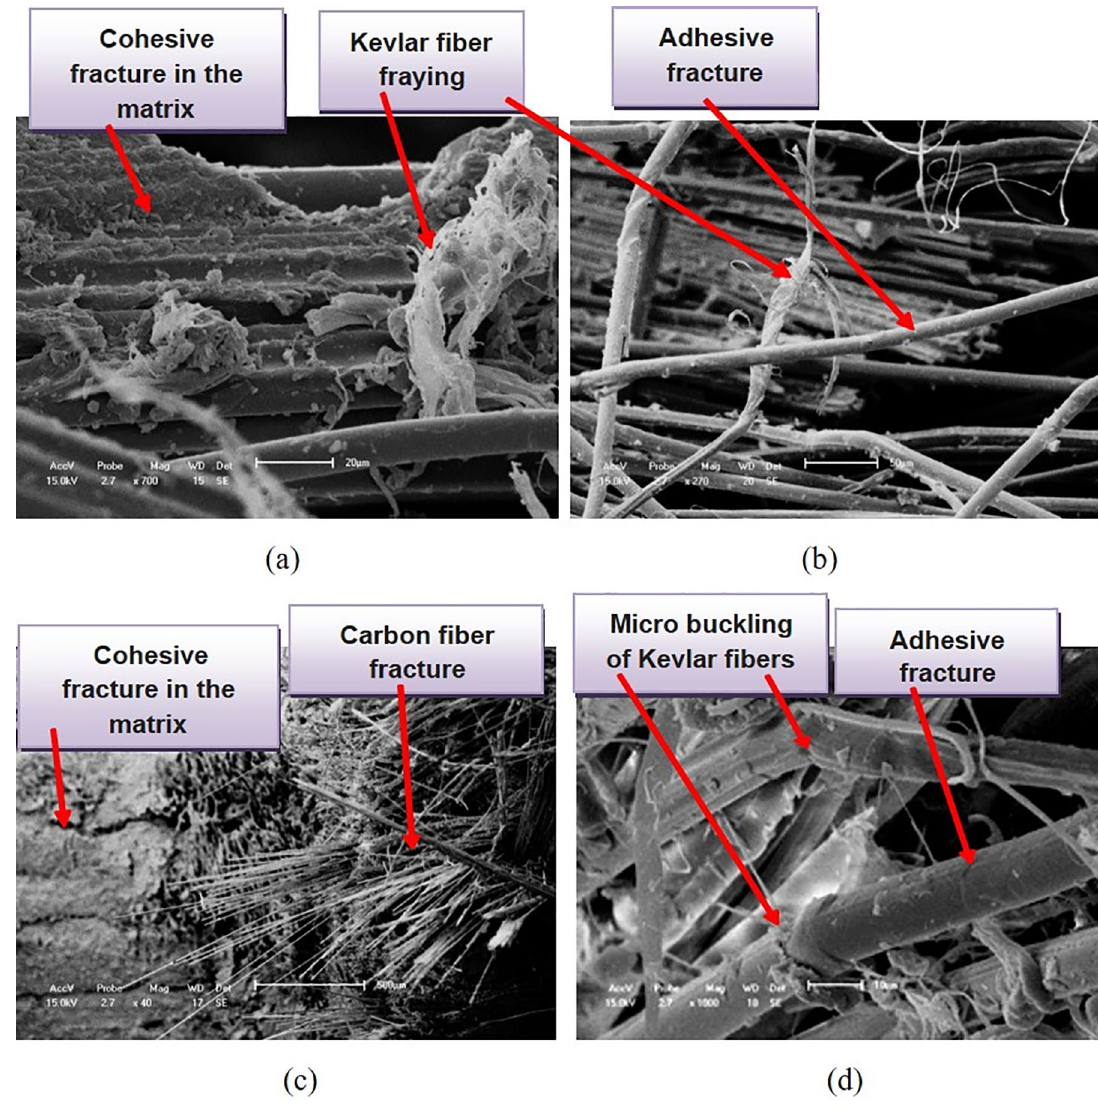
Figure 9. Mechanical fracture of the specimens: (a) CLCO; (b) CLKO; (c) CLCH and (d)